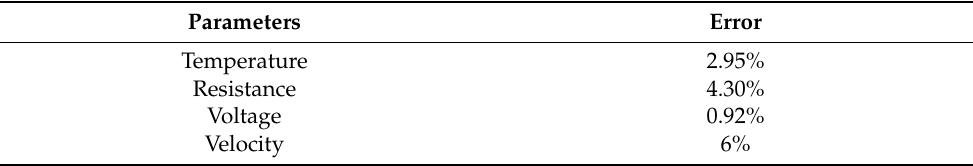
Table 4. Results of the uncertainty